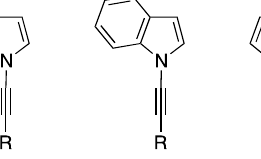
Figure 1. Examples of N -alkynyl azoles.